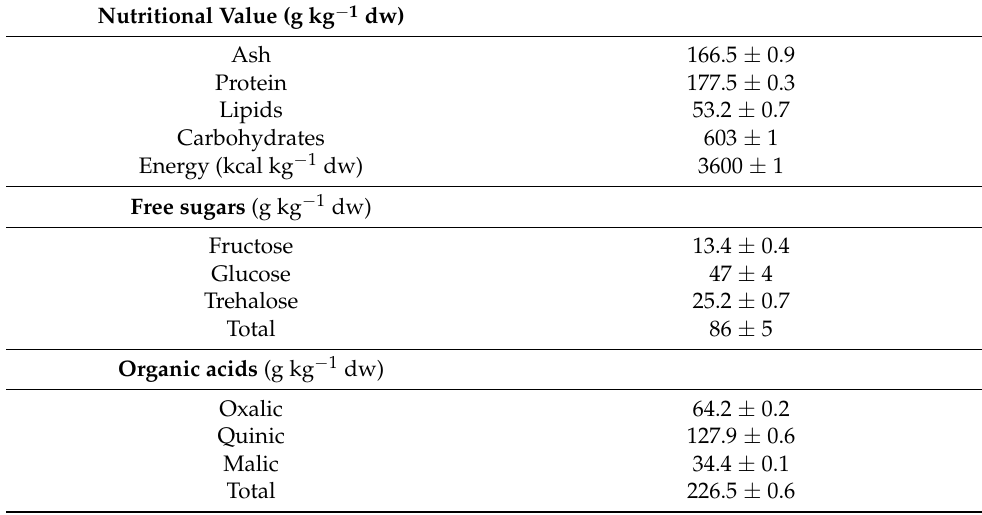
Table 1. Nutritional value and hydrophilic compounds of L. canadensis (mean ± SD, n =